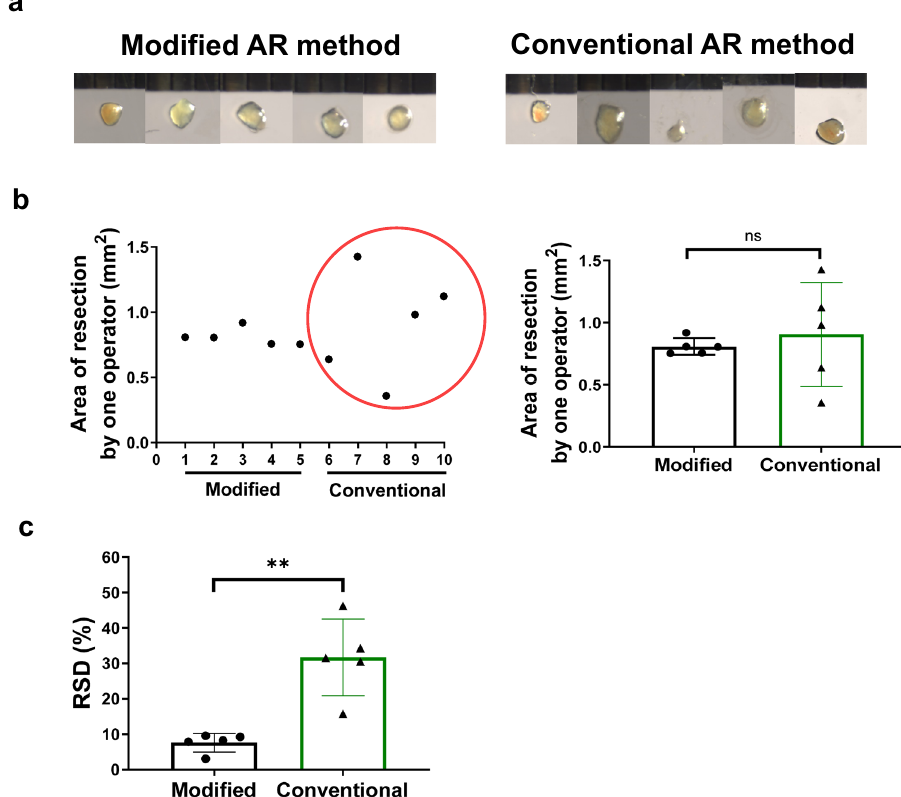
Fig. 3 Homogeneity and reproducibility of modi fi ed and conventional apical resection methods in 1-day-old neonatal mice. a Representative images of resected left ventricle (LV) apex using modi fi ed apical resection (AR) method (left panel, n = 5) and conventional AR method (right panel, n = 5) by one operator. b Corresponding variation of resected LV apex areas (left panel) and mean value of resected apex areas using modi fi ed versus conventional AR methods (right panel) by the same operator. c Relative standard deviation (RSD) analysis for resected LV apex areas by modi fi ed versus conventional AR methods. ** P < 0.01; ns not signi fi cant. All data are expressed as means ± SD. Table 1. Standard deviation and relative standard deviation of the resected areas of left ventricle apex in the modi fi ed and conventional apical resection methods for each operator.